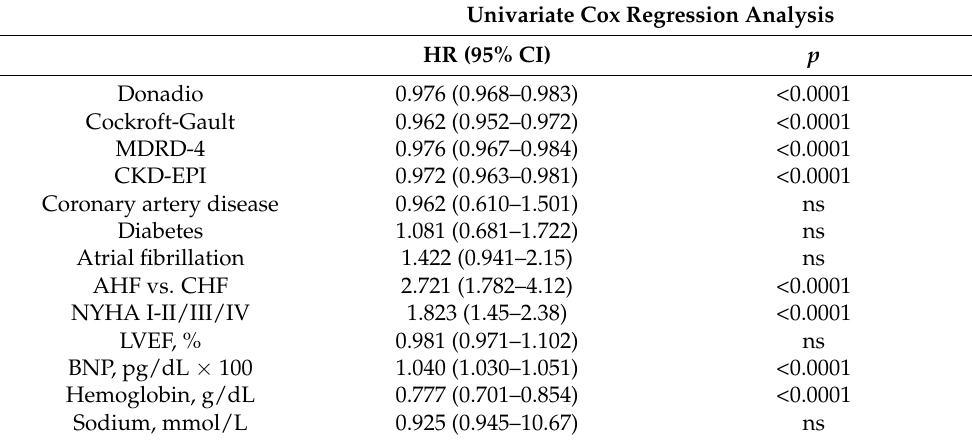
Table 3. Univariate Cox proportional hazards survival analyses.